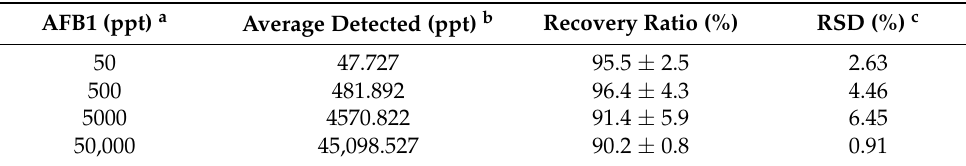
Table 3. Comparison of the developed AFB1 aptasensors.